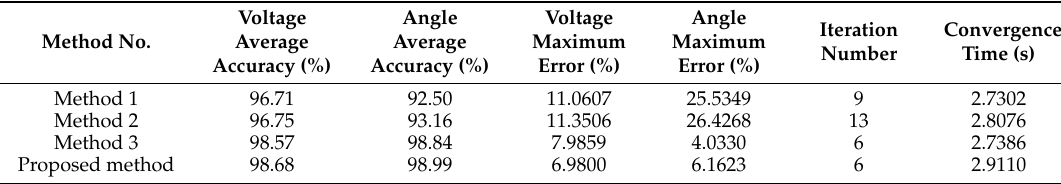
Table 9. The results of state estimation of different cases in 118 bus system.